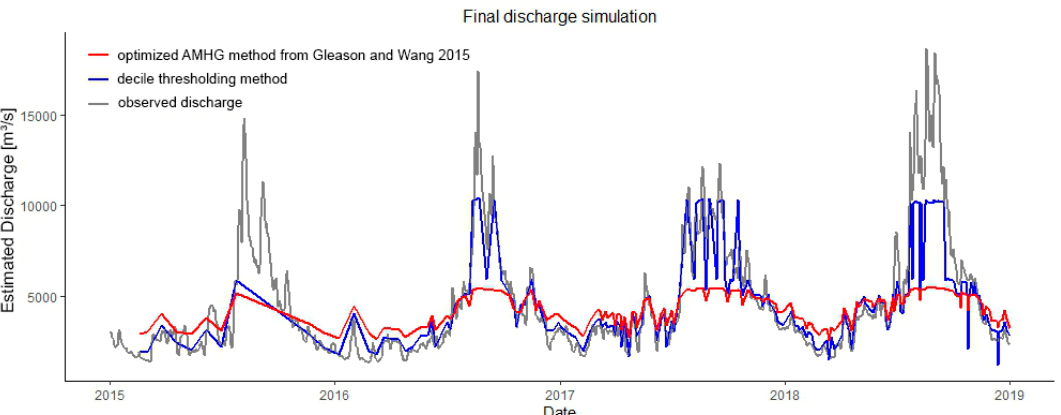
Figure 16. Final discharge estimation by decile thresholding method compared to optimized AMHG method.